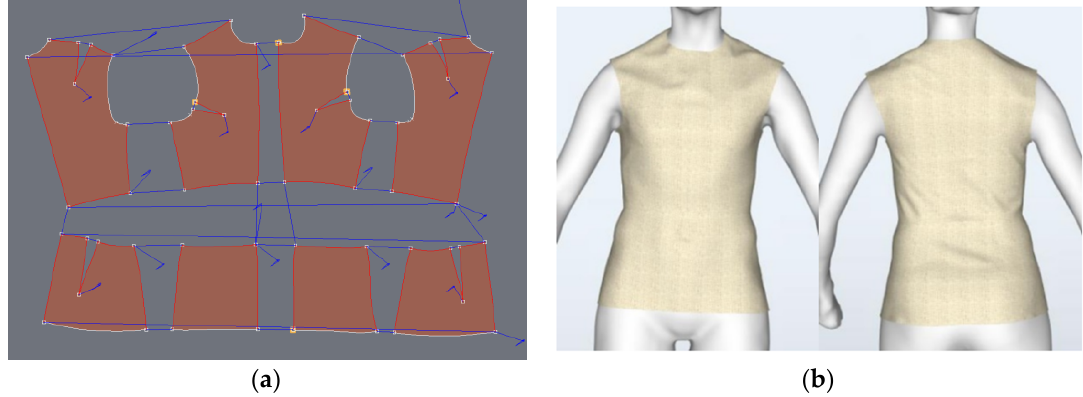
Figure 3. ( a ) 2D pattern from Design concept, ( b ) Garment [sewn] on 3D virtual model.